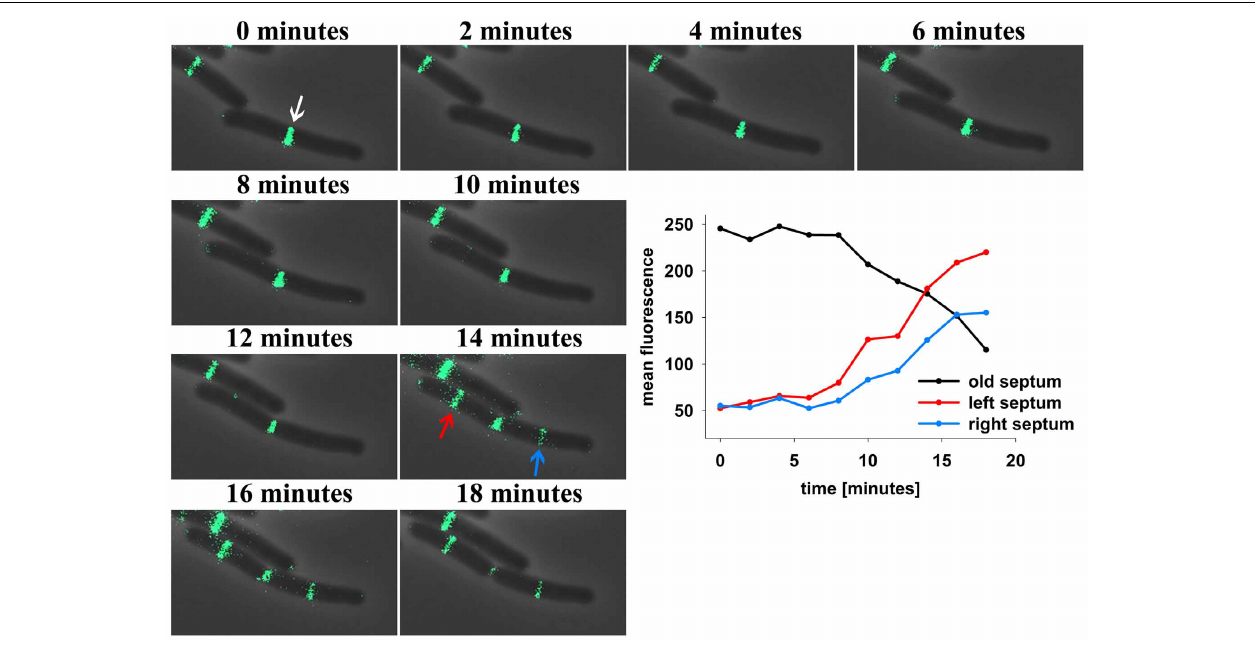
FIGURE 1 | Time lapse analysis reveals DivIVA-GFP dynamics in B. subtilis . Cells expressing DivIVA-GFP under its native promoter were grown on agarose slides supplemented with LB at 37 ◦ C and analyzed microscopically. Pictures were taken every 2min. After division DivIVA-GFP is mostly located at midcell or at one pole (white arrow). After 14min